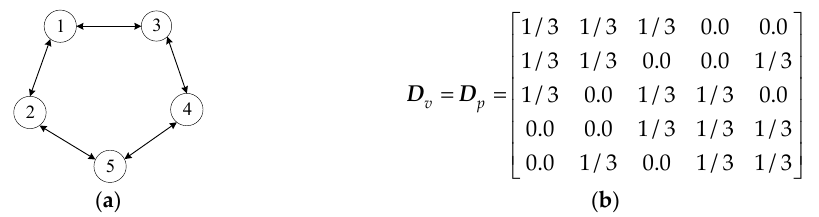
Figure 7. Optimal topology and the corresponding matrix D . ( a ) the optimal topology; ( b ) the corresponding matrix.